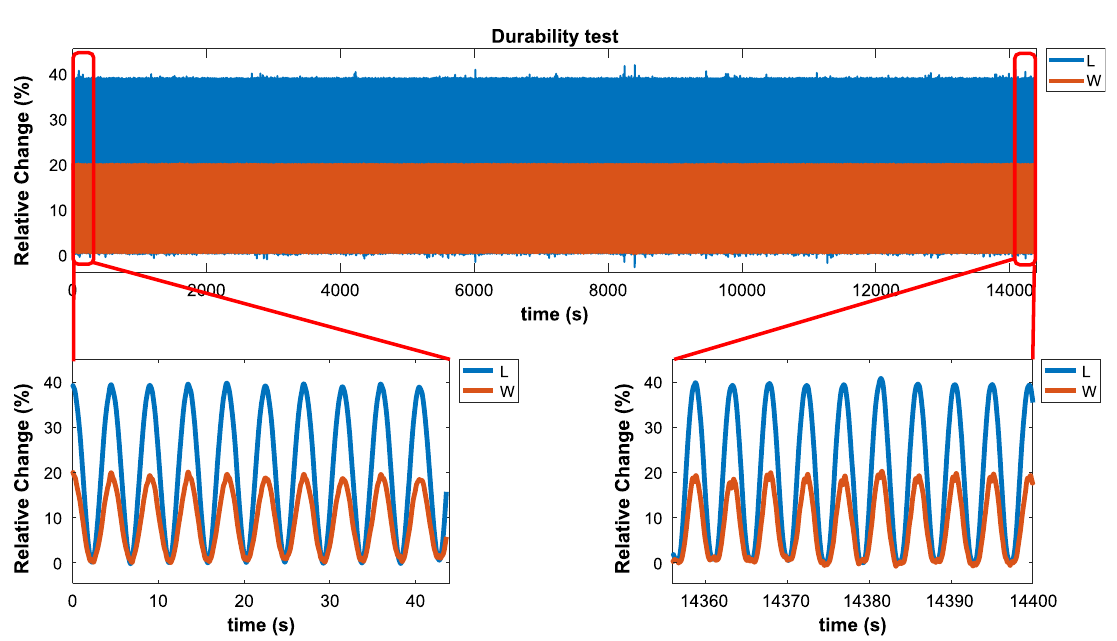
Figure 14. Durability test result with sinusoidal mechanical stimulation. The figure on the left is the output signal from the first seconds of the durability test and the figure on the right is the output signal in the last seconds of the durability